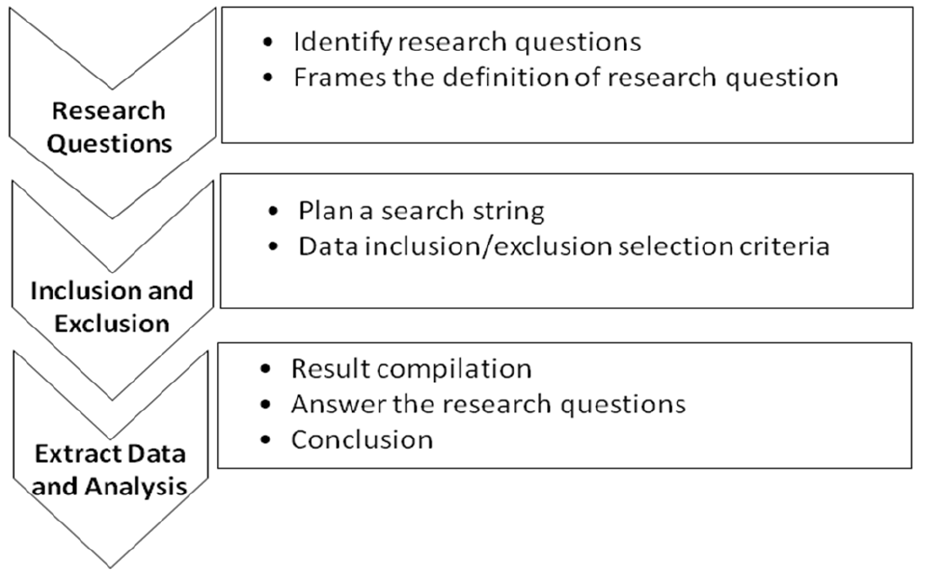
Figure 1. Survey protocol plan.